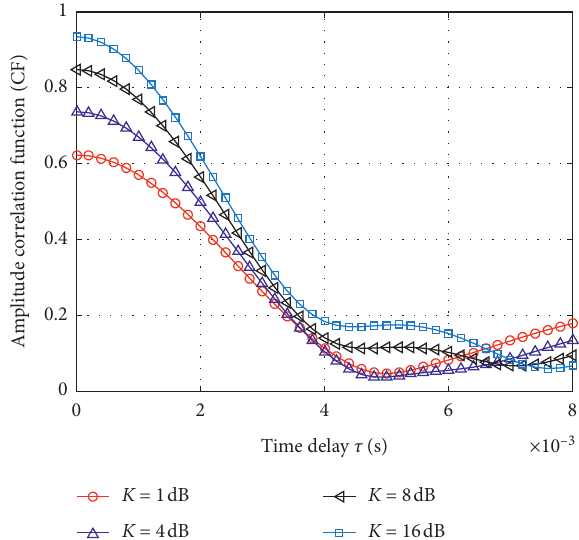
Figure 5: Amplitude correlation function (CF: LoS +NLoS) for different K factors with different time delay ( t � 0s, d � 0.7 λ , v �